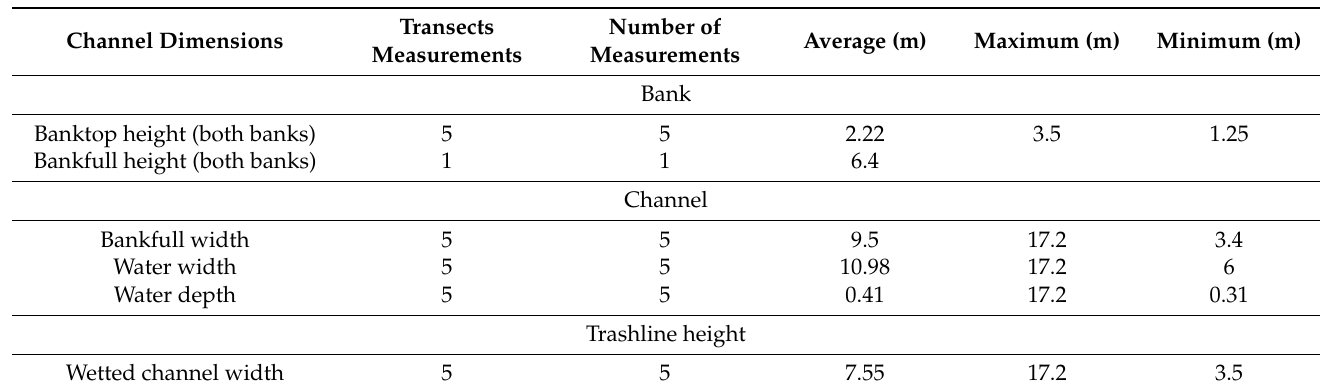
Table 8. Summary of observations in Section L.